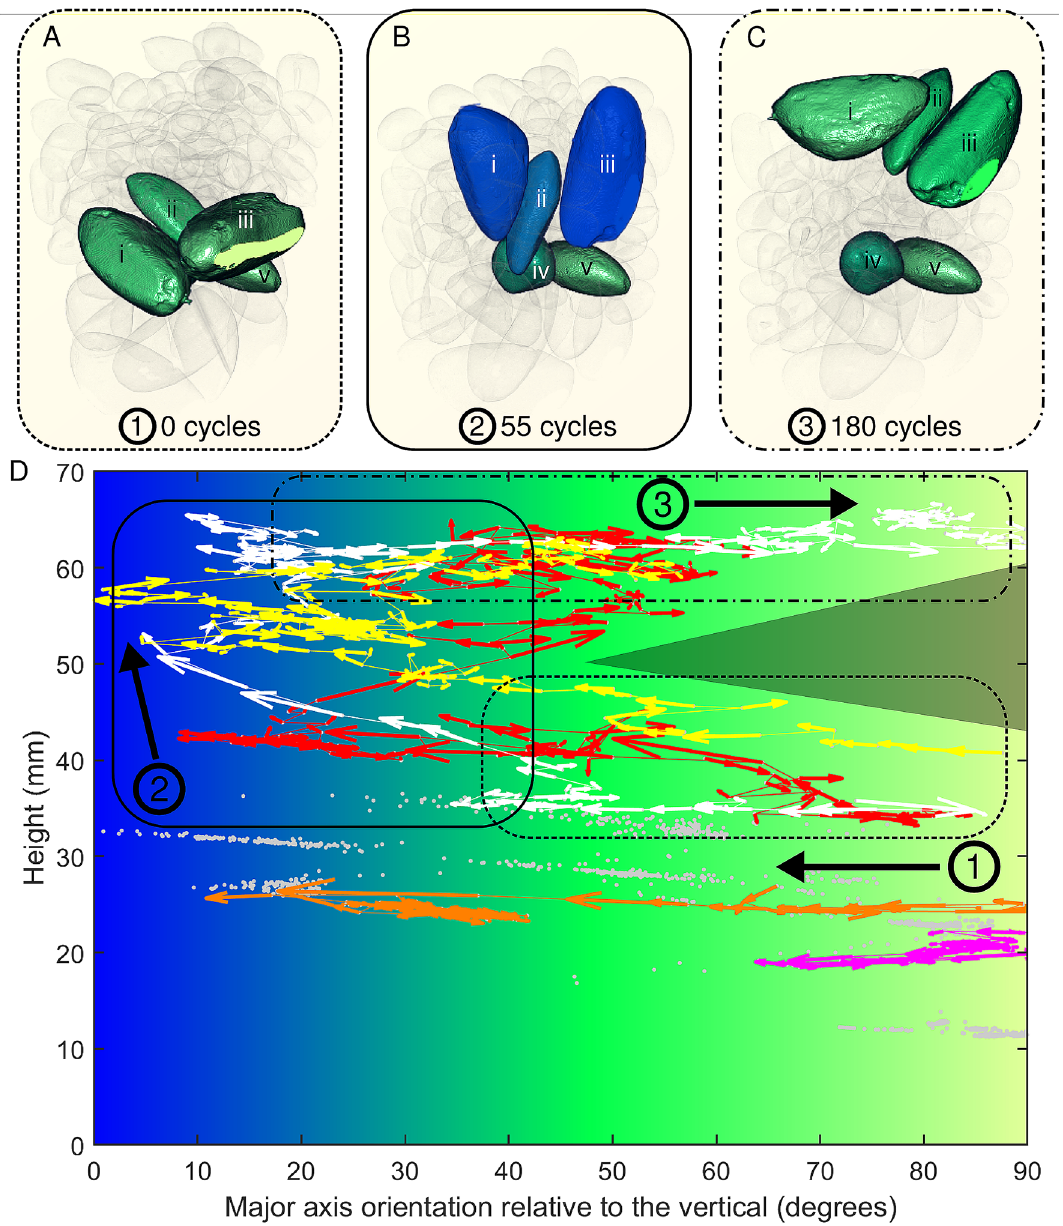
Figure 2. ( A – C ) Visualisations of three rising Brazil nuts (i, ii, iii) and two of the non-rising Brazil nuts (iv, v) coloured according to their orientation. ( D ) Orientation-height phase space for all of the Brazil nuts for all time points, with orientation measured as the angle of the major axis of the moment of inertia of the Brazil nuts relative to the vertical laboratory axis and height corresponding to the vertical centre of mass of each nut. Trajectories of rising nuts i, ii and iii are represented in white, red and yellow respectively, with the trajectories of non-rising nuts iv and v shown in orange and magenta respectively. The remaining non-rising Brazil nuts are represented in